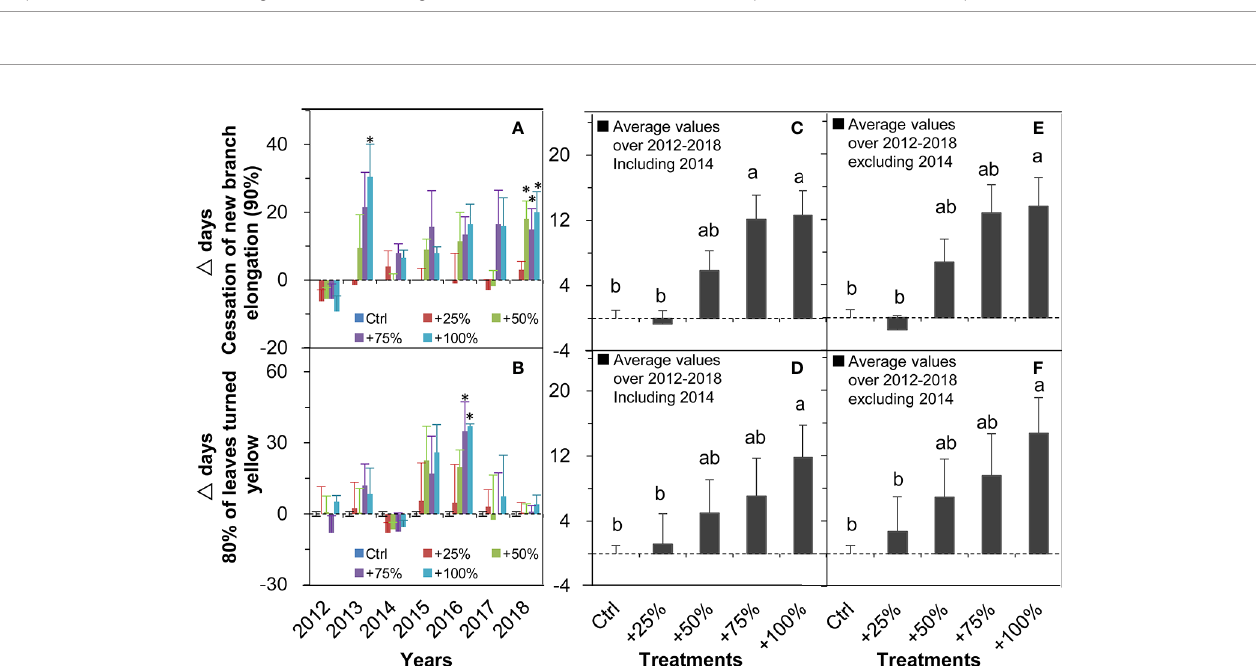
FIGURE 5 | Relative changes ( △ days; mean ± SE) of the two autumn events of N. tangutorum after water addition treatments (+25% to +100%) compared with the control (Ctrl). Positive and negative values represent delayed and advanced days, respectively. A, C , and E represent the cessation of new branch elongation. B, D, and F represent 80% of leaves turned yellow. * indicates signi fi cant differences at the P < 0.05 level compared with values in control